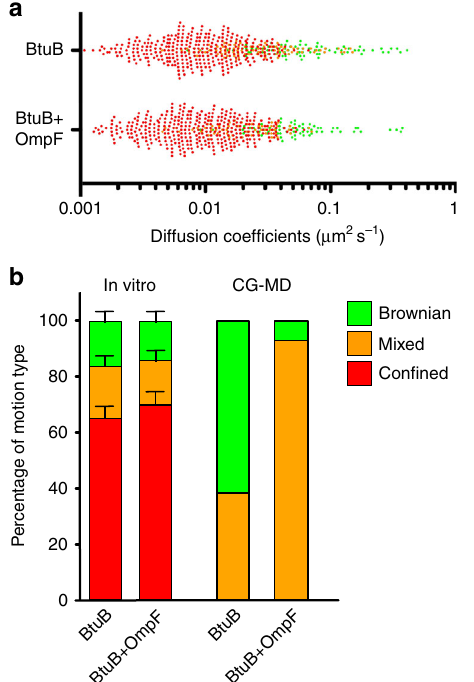
Fig. 3 Comparing OMP diffusion in vitro and in simulations. a In vitro diffusion coef fi cients and classi fi cation of motion type (Brownian, green; con fi ned, red; mixed, orange) for a supported bilayer containing a high area density (ca. 30%) of BtuB or BtuB and OmpF. See ref. 8 for further details. b Comparisons of the fraction of different classes of diffusional motion for in vitro systems and CG – MD simulations. The experimental single particles (error bars show standard error of mean, n = 3) and simulated OMP trajectories were both analysed using PaTrack 39 . The last 5 µ s of the 20 µ s simulations were used. Further details of the evolution of the diffusional motion as a function of time are available in Supplementary Figures 5,